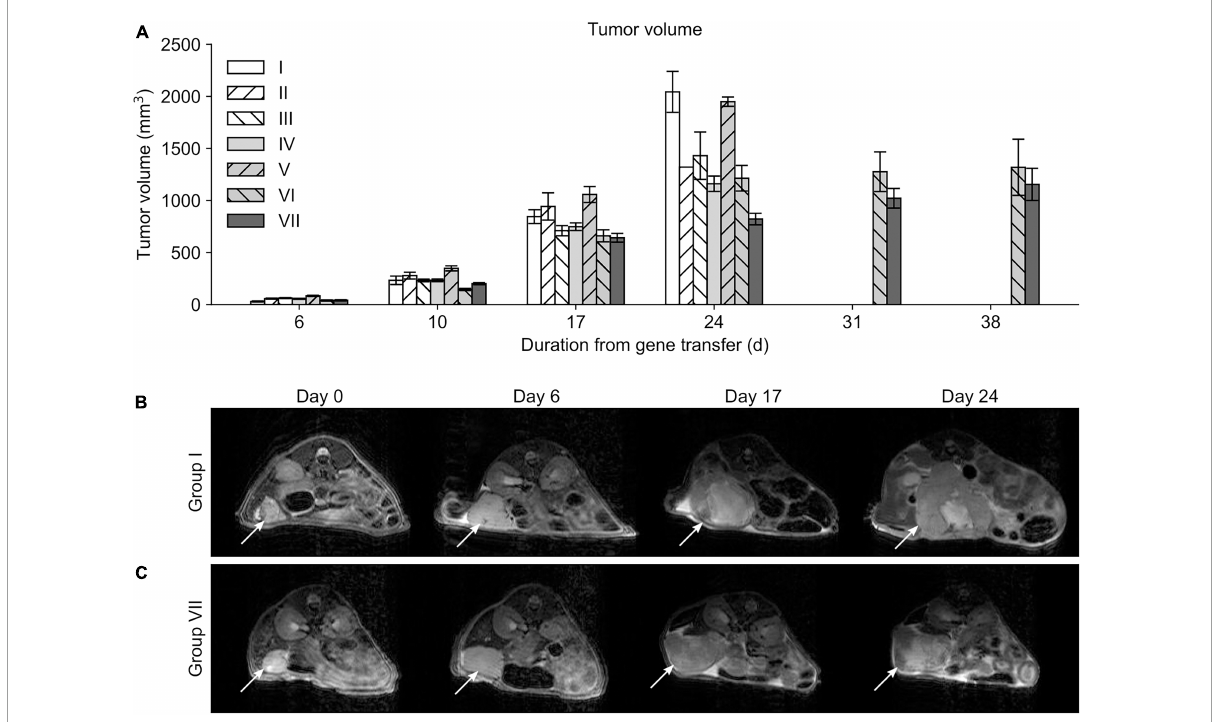
FIGURE4 Mean tumor volumes. (A) Differences in tumor volumes were first observed at day 10 only between the groups V and VI. Only mice belonging to the study groups VI and VII survived long enough to be measured at timepoints 31 and 38 days. Serial MRI scans from the group I (B) and VII (C) demonstrating tumor growth during the follow-up. Location of the tumor is indicated with a white